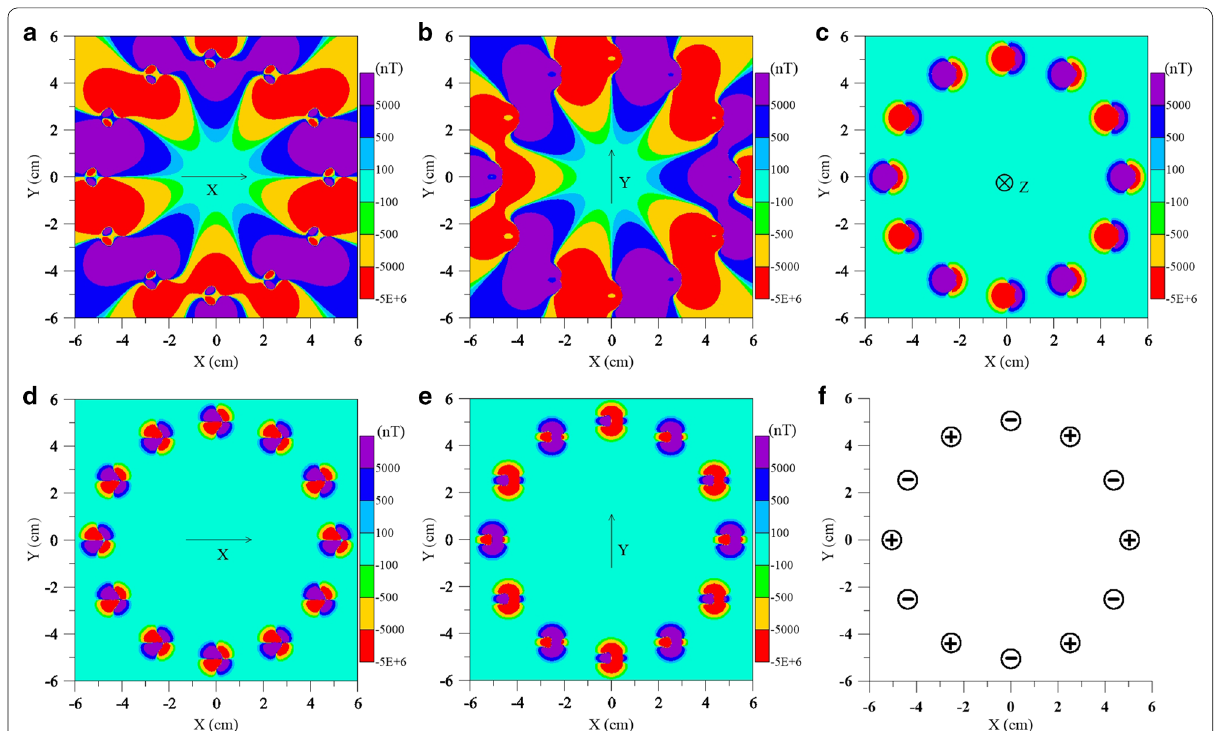
Fig. 4 Contour map of magnetic field distribution on different components in middle cross section of the furnace with composed of 12 conventional solenoids ( a – c ) and new heating elements ( d , e ). f The position of the solenoids and the corresponding current direction in adjacent. Letter X, Y, Z in the middle of the graph represents the direction of the magnetic